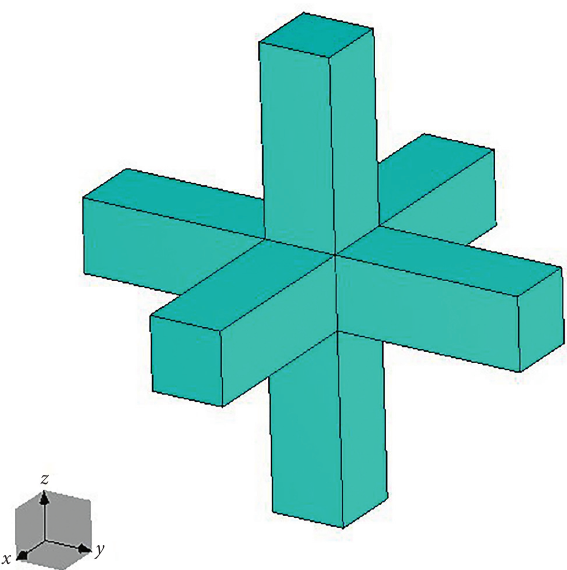
Figure 4: 3D model of the cross-shaped